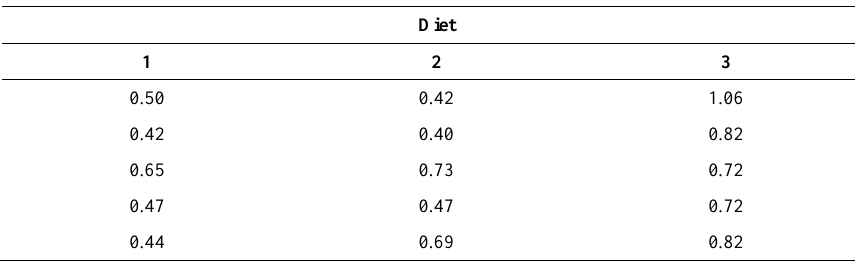
Table 3. The 15 observations of pregnant rats used to study the e ff ect of three diets on dietary residual zinc in